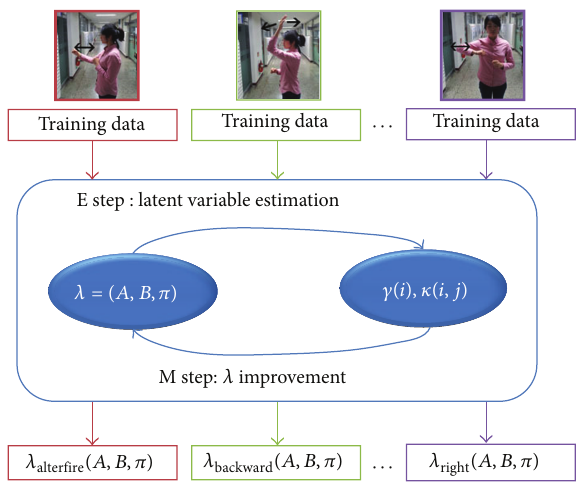
Figure 6: Baum-Welch algorithm for learning